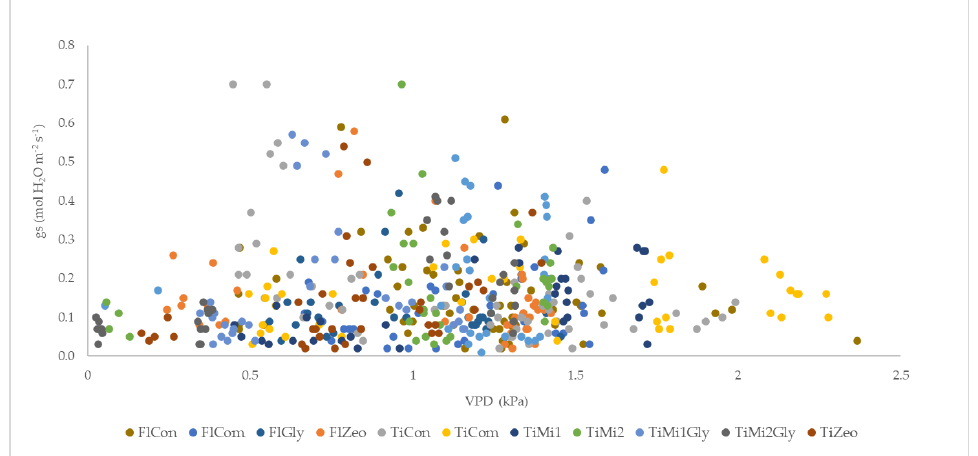
− 2 s − 1 ) response to increasing vapor pressure 2 O m